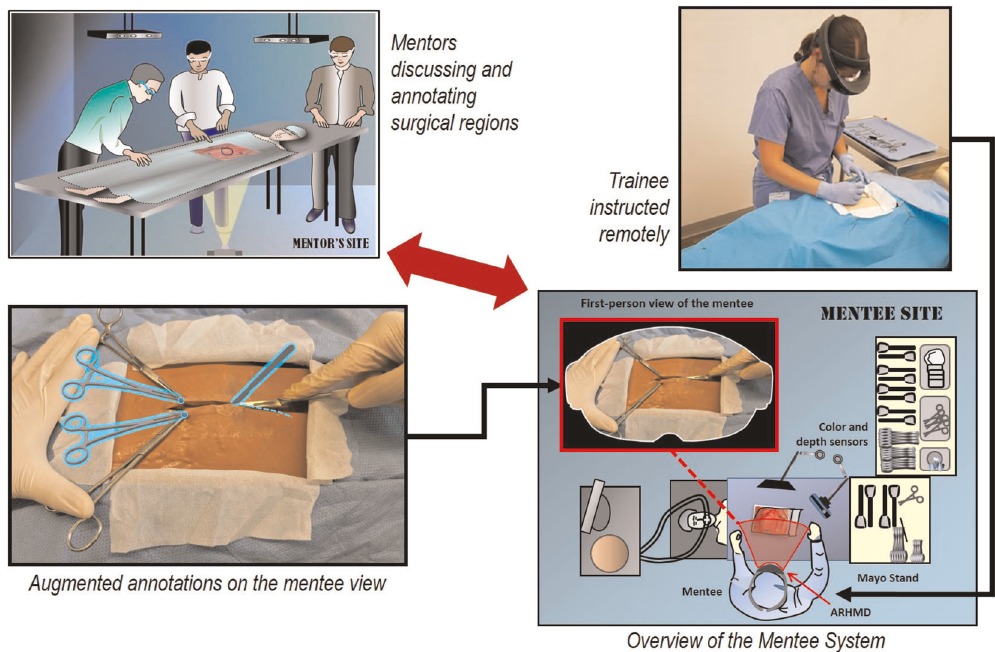
Fig. 1 Schematic of the STAR platform. By integrating image stabilization routines with the ability to project mentor-authored surgical instructions onto the operating fi eld, this portable system is designed to convey clinical expertise in austere scenarios. The trainee showcased gave written informed consent to have their photo used for this